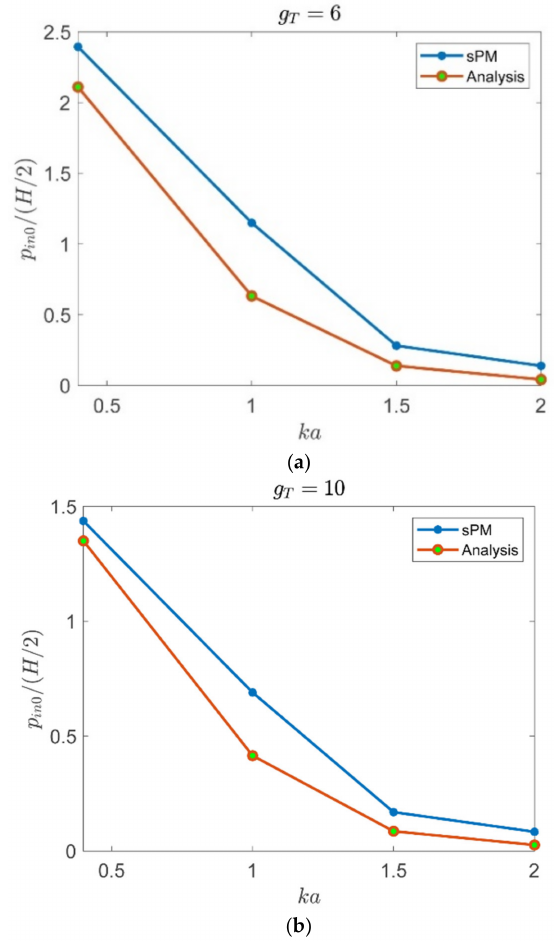
Figure 10. Inner air pressure of the OWC obtained by the sPM as compared with analytical results [26]. ( a ) g T = 6, ( b ) g T =